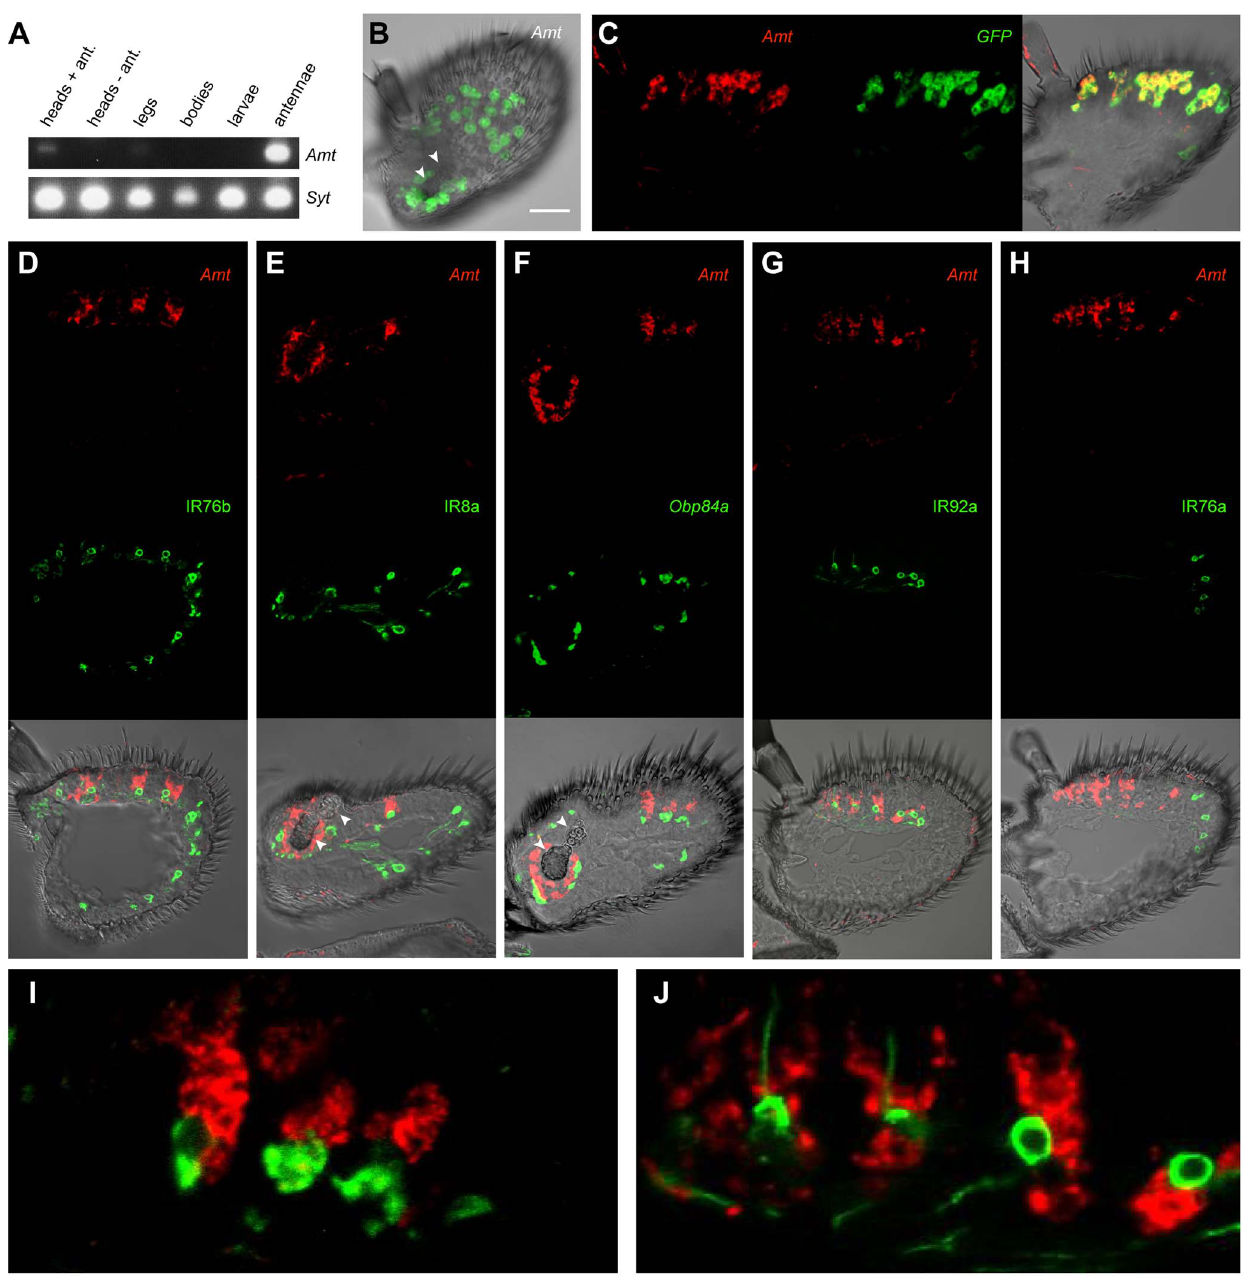
Figure 4. Expression of Amt. (A) RT-PCR analysis of Amt expression in CS. Synaptogmin was used as a positive control. (B) Whole-mount confocal image of a third antennal segment of an Amt-GAL4; UAS-mCD8::GFP fly. GFP expression is seen in large, amorphous auxiliary cells, but not in neurons. White arrowheads indicate the sacculus here and in panels E and F. Scale bar =30 m m. (C) Confocal image of an in situ hybridization to an antennal section from an Amt-GAL4; UAS-mCD8::GFP fly using antisense probes for Amt (red) and GFP (green). The two probes co-localize. (D, E, G, H), confocal images of antennal sections labeled with an antisense probe for Amt (red) and an antibody against GFP (green) driven by (D) IR76b-Gal4 , (E) IR8a-Gal4 , (G) IR92a-Gal4 , and (H) IR76a-Gal4 . IR76b-Gal4 and IR8a-Gal4 are co-receptors that label at least one ORN in each surface coeloconic sensillum type (ac1–4). IR8a-Gal4 also labels coeloconic ORNs in the third chamber of the sacculus. Amt is detected in larger neighboring auxiliary cells in a subset of the coeloconic sensilla. (F) Confocal image of an in situ hybridization to an antennal section from a CS fly using antisense probes for Amt (red) and Obp84a (green). Amt is expressed in different auxiliary cells from those that express Obp84a , which is also expressed in coeloconic sensilla. (G) Expression of Amt on the antennal surface is found surrounding the IR92a ammonia receptor-expressing neurons, which are in ac1. (H) Amt is not detected in ac4 sensilla, which contain ORNs that express IR76a . (I, J) Higher magnification images of (F) and (G) respectively.